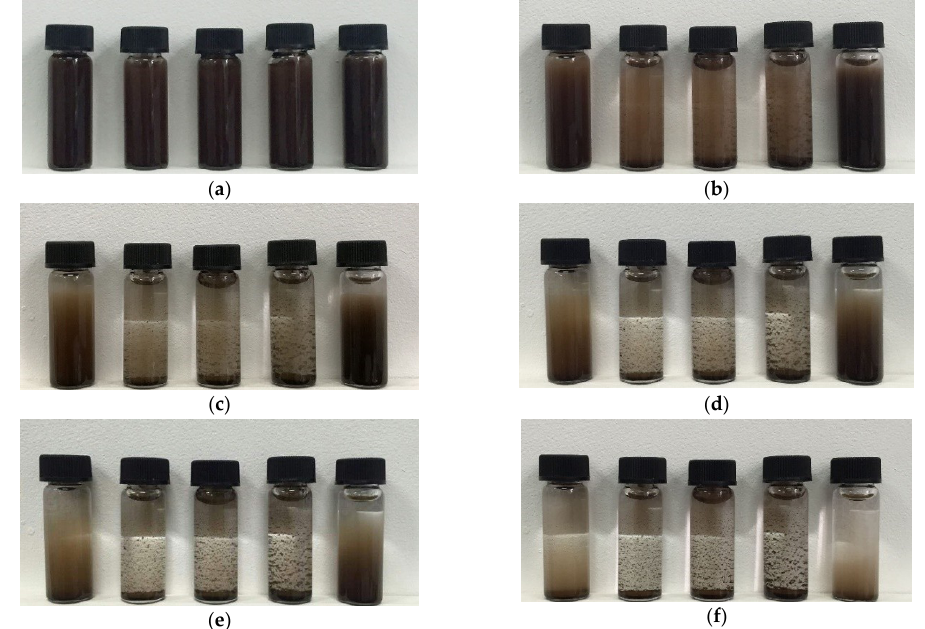
Figure 8. The dispersity of FCMSs in the solutions with different pH. ( a ) Initial state; ( b ) 2 h; ( c ) 5 h; ( d ) 8 h; ( e ) 11 h; ( f ) 24 h. Images in each picture from left to right were the solution with the pH of 2, 6, 7, 8 and 12.